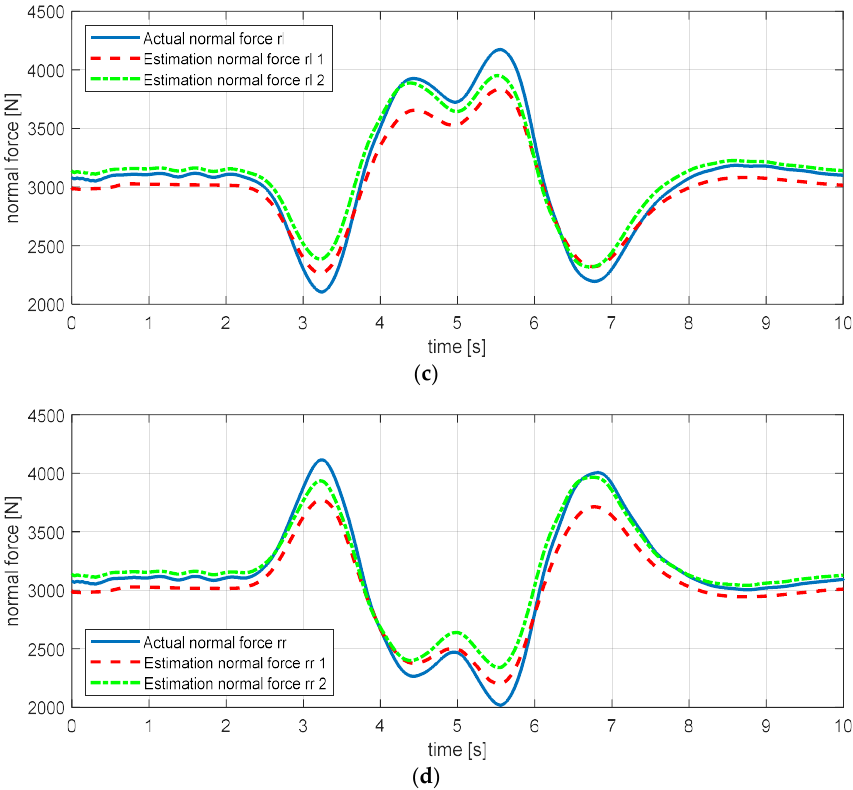
Figure 13. Estimation simulation result for the normal force. ( a ) Normal force—fl; ( b ) normal force—fr; ( c ) normal force—rl; ( d ) normal force—rr.